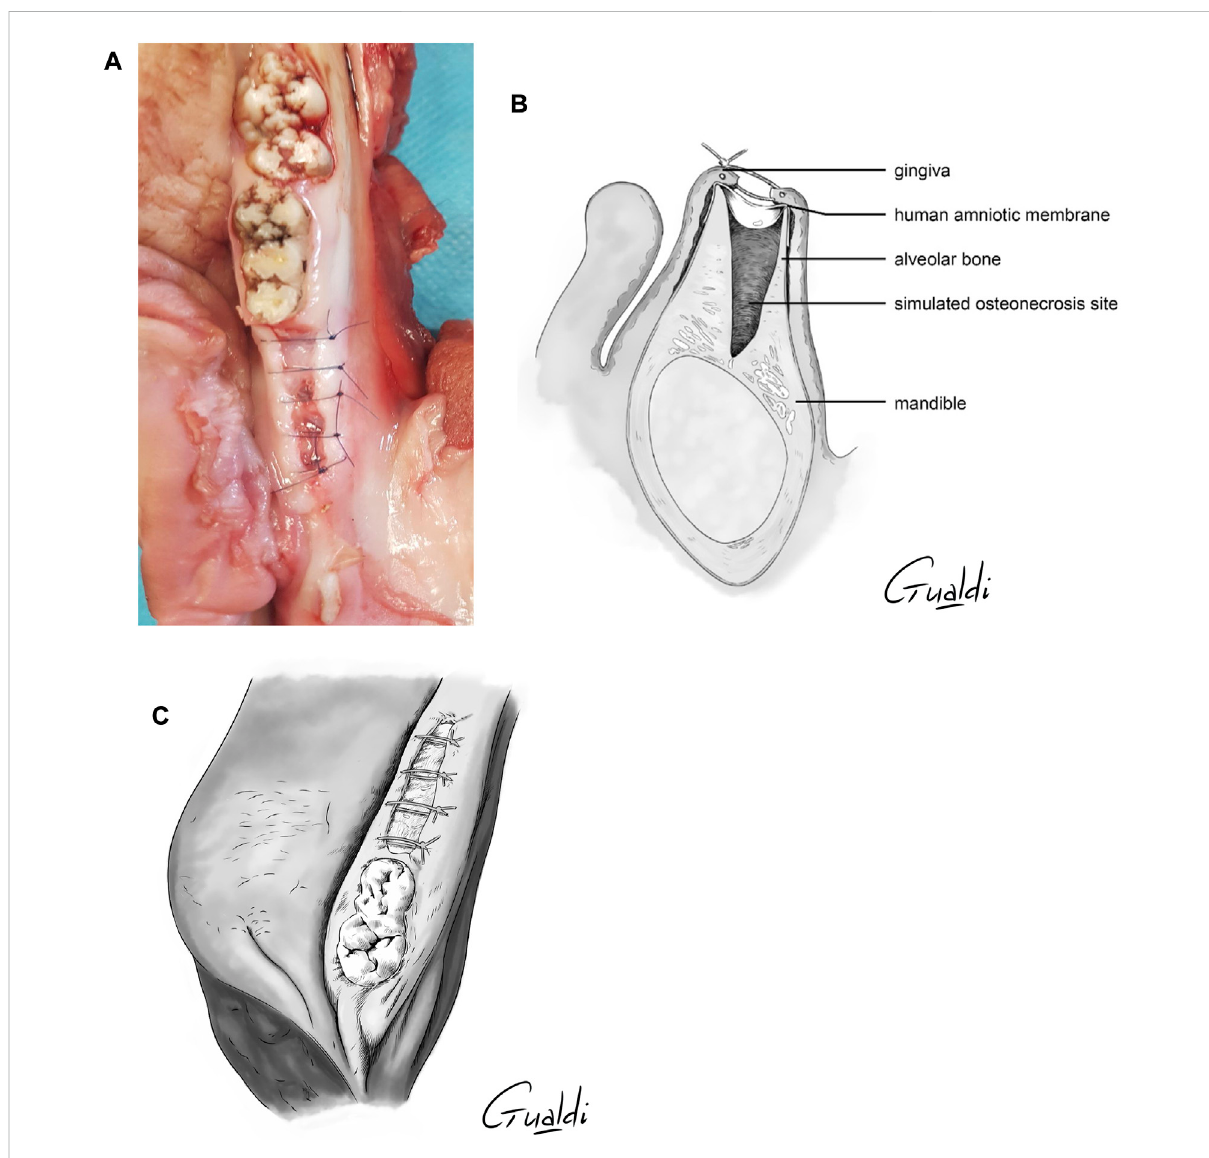
FIGURE 5 hAM implantation with partial coverage. The gingiva was sutured above the hAM, but leaving the hAM exposed in the oral cavity. (A) Photography; (B) Sagittal section illustration; (C) Upper view